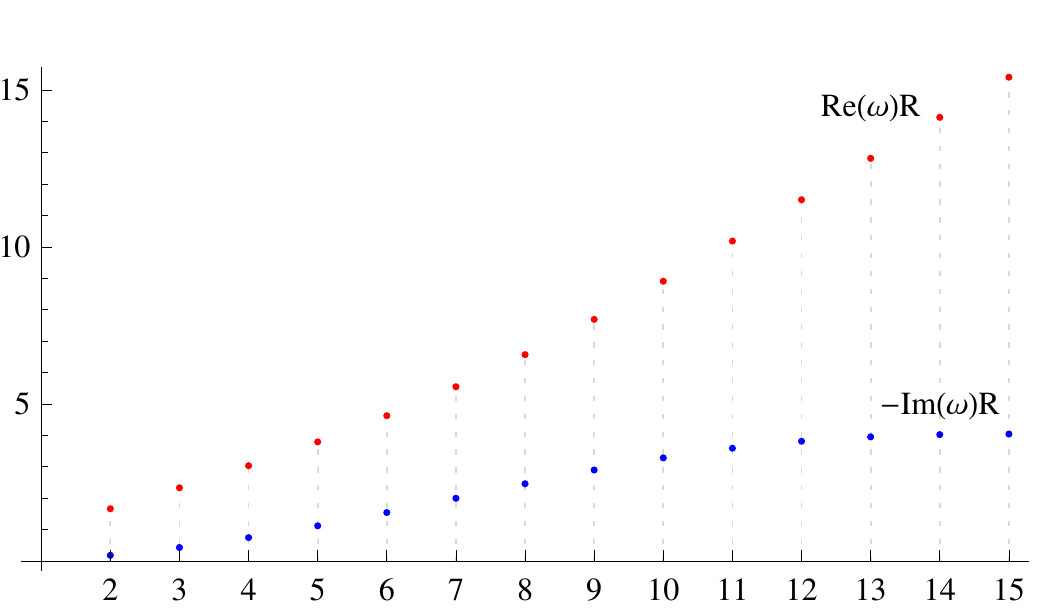
(cid:11) for D = 5 (upper, red) and D = 6 (lower, blue): e